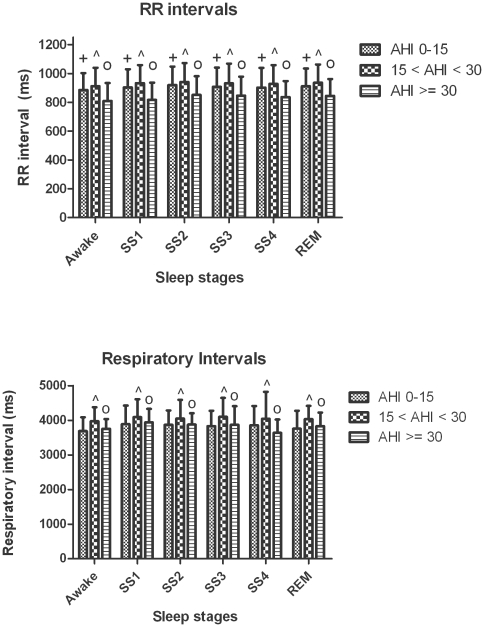
Group and sleep related comparison of RR interval and respiratory interval.The plus indicates that the differences in RR interval between the no/mild and severe OSA groups are significant (p<0.0001). Similarly, the circle and hat indicates the significance (p<0.0001) in RR interval or respiratory interval differences between moderate and severe or no/mild OSA groups respectively.